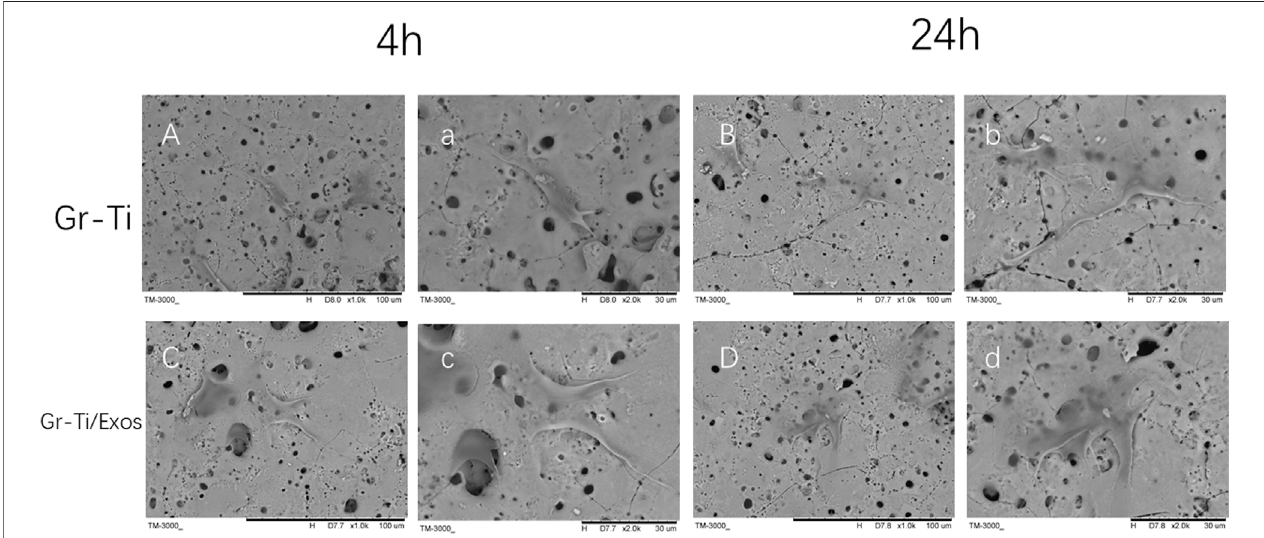
FIGURE 3 | Adhesion of ADSCs to scaffolds (SEM): The morphology of ADSCs in Gr-Ti/Exos group were better than that in Gr-Ti group. [ (A – D) × 1,000; (a – d) × 2,000].